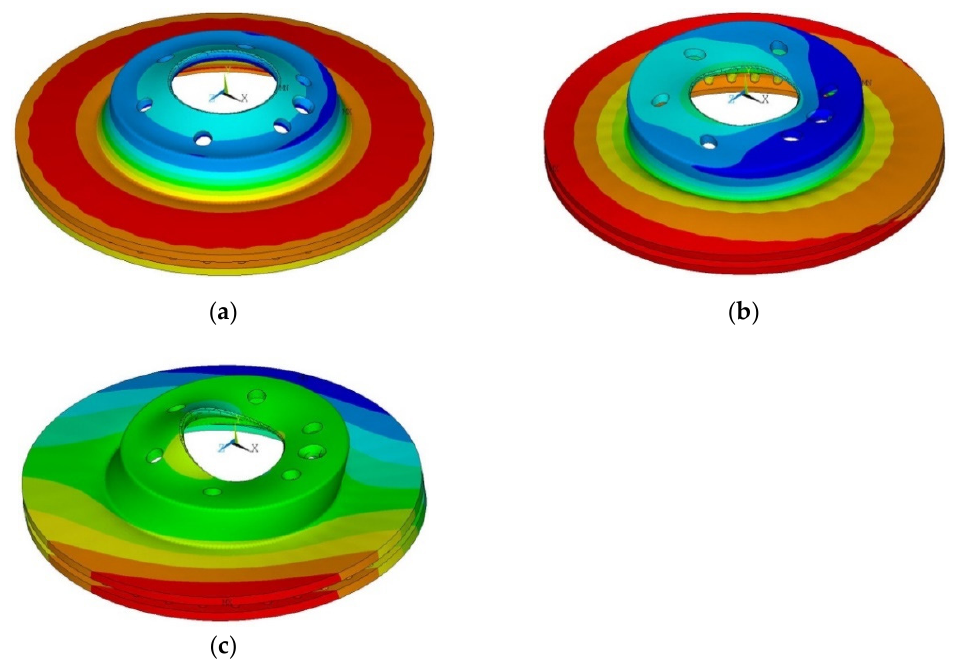
Figure 4. In-plane modes: ( a ) radial mode; ( b,c ) tangential modes including ( b ) shear mode and ( c ) compression mode.